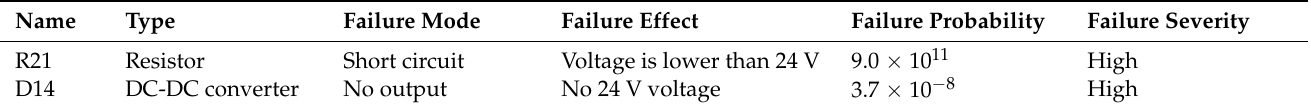
Table 10. FMECA table after ScO application.